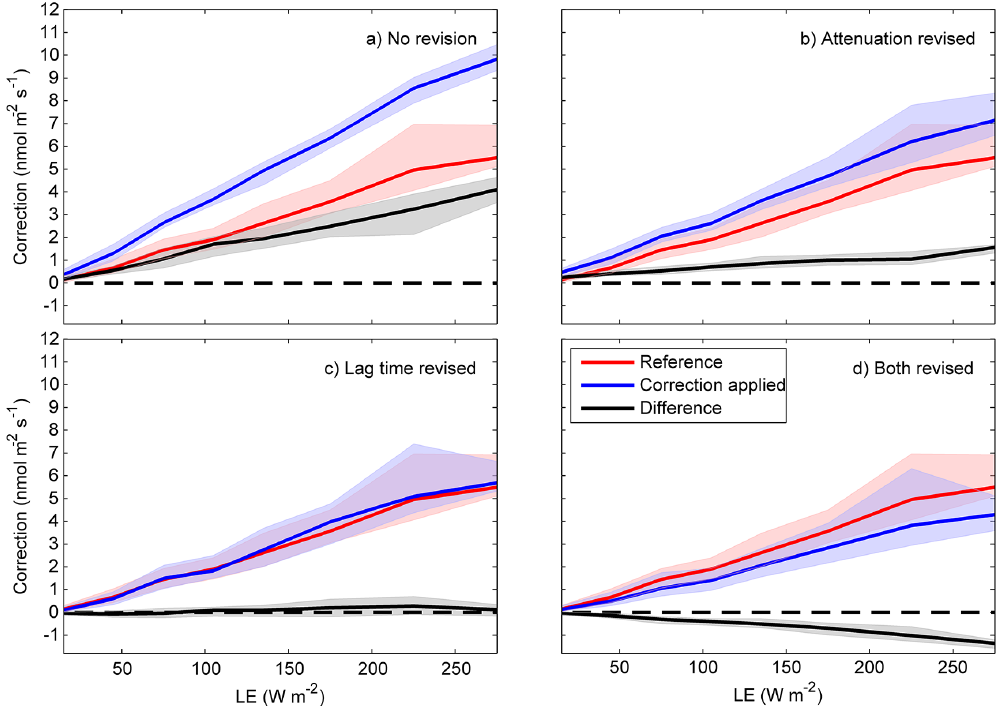
Figure 11. Combined error in density and spectroscopic corrections as a function of latent heat flux if external H 2 O measurements are used in Eq. (5). FGGA CH 4 fluxes were corrected with LI-7000 H 2 O measurements (blue colour) and with FGGA-internal H 2 O measurements (red colour) which yield correct values and are shown for comparison. The difference between these two, i.e. error in the correction using external H 2 O, is plotted with black colour. The lines show medians and the areas show interquartile range around the medians. (a) The correction is calculated by maximising LI-7000 w 0 χ 0 v . (b) Maximum of LI-7000 w 0 χ 0 v is adjusted to match the maximum of FGGA w 0 χ 0 v . (c) Lag time of LI-7000 w 0 χ 0 v is adjusted to match the lag time of FGGA w 0 χ 0 v . (d) Both lag time and maximum of LI-7000 w 0 χ 0 v are set to match FGGA w 0 χ 0 v . Data measured during the whole campaign (635 points) were divided into 8 latent heat flux bins before plotting. The dashed lines highlight the zero line. See also Fig. 10 for examples from two contrasting averaging periods.